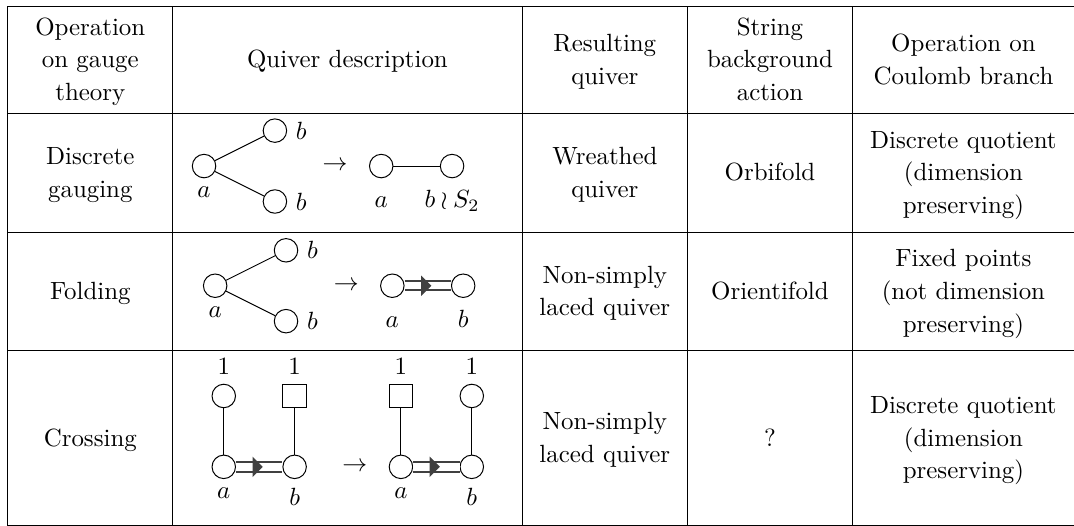
Table 1 . Discrete actions on the